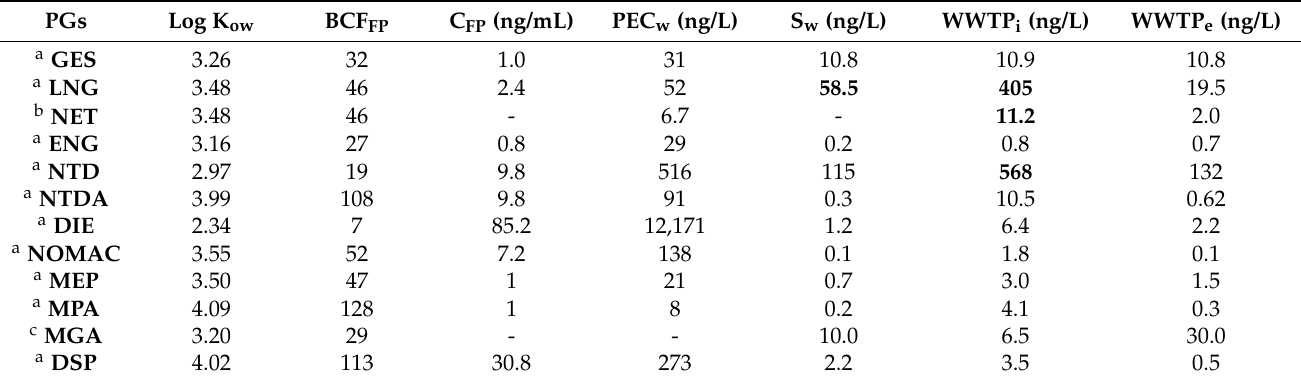
Table 6. Bioconcentration factor in fish plasma (BCF FP ) and concentration in the plasma of a fish (C FP ), which correspond to the human plasma therapeutical levels, and predicted effect concentration (PEC w ) values. Data in bold are above PEC w , considering the average between the minimum and the maximal levels measured in surface waters (S w ), WWTP influents (WWTP i ) and effluents (WWTP e ) presented in Table